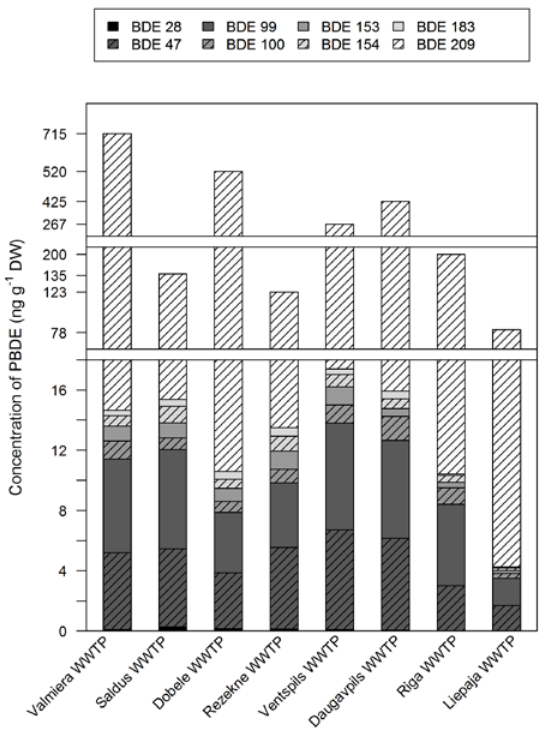
Figure 1. Concentrations of PBDEs in sewage sludge from eight urban WWTPs in Latvia.